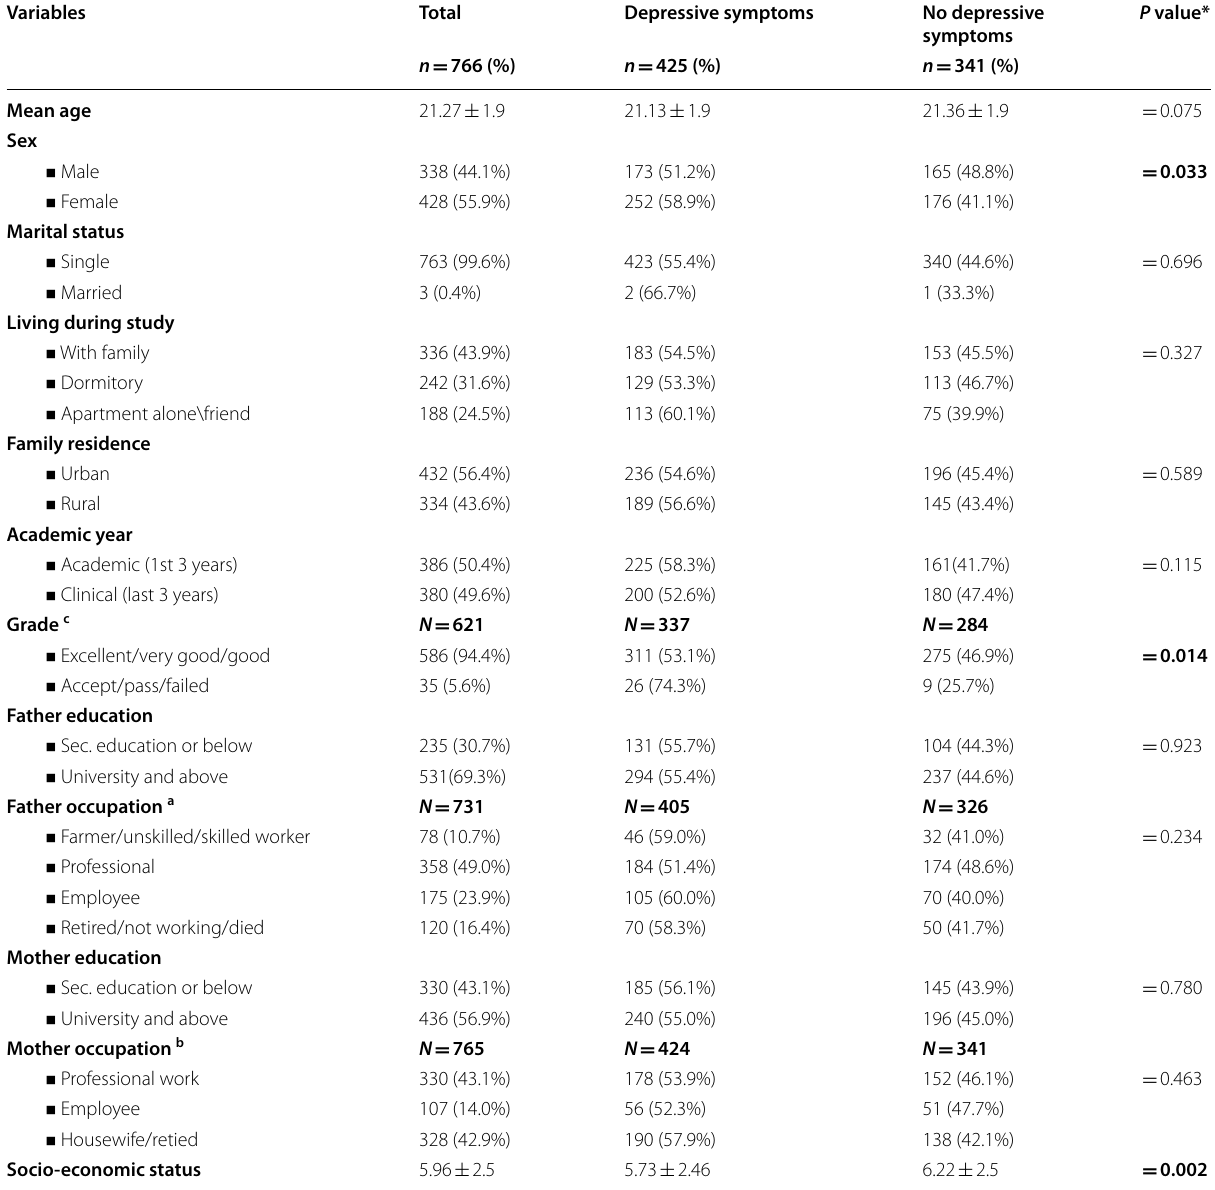
Table 1 Association between students’ characteristics and depressive